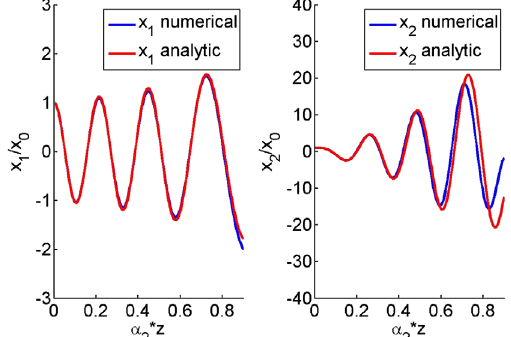
FIG. 2. Numerical and analytic solutions of the equations of motion [Eq. (2)] for both the head (1) and tail (2) particles. When α z equals 1, the tail particle has lost all of its 2